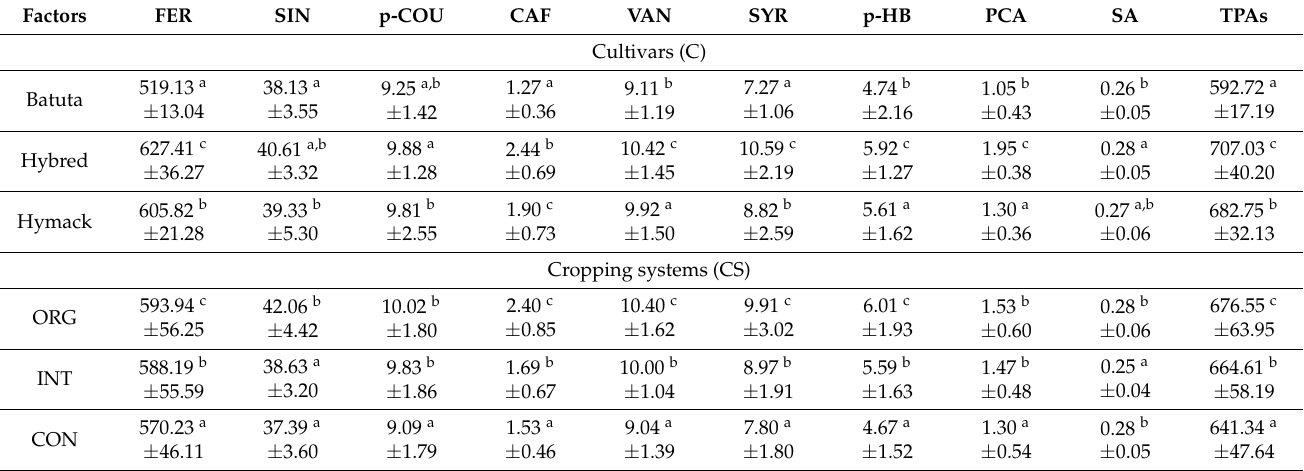
Table 3. Phenolic acid (PA) composition of wheat grain [ µ g g − 1 ], mean values for